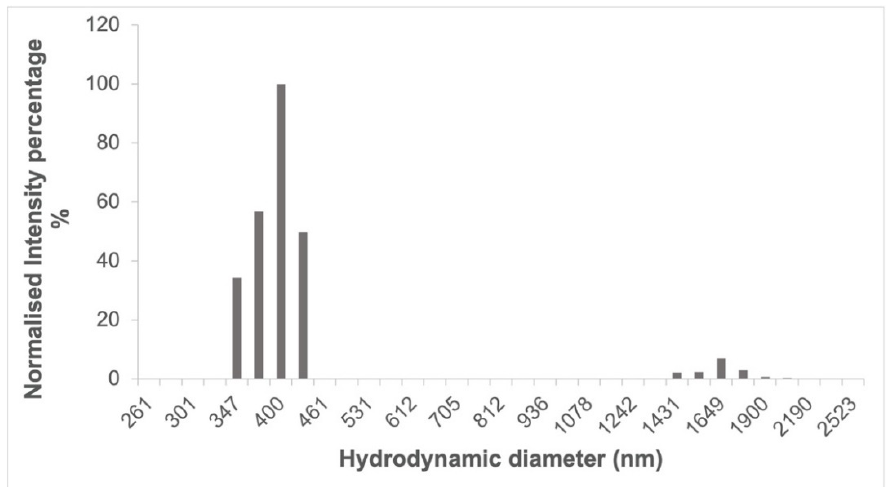
Figure 4. X-ray diffraction spectra for pure α -CD and the synthesized α -CD-NS.